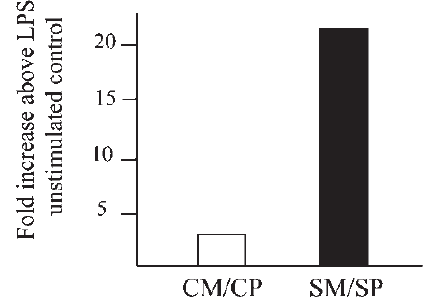
Figure 3. LPS-induced TNF a release is higher in ex vivo hepatocytes generated from the adult IUGR offspring of prenatal calorie restricted rats. We generated primary hepatocyte cell lines as described under “Methods” and assessed the LPS-induced TNF- a release by stimulating them for 5h with purified LPS (100ng/ml), and observed that the TNF- a release was significantly higher in the SM/SP ð n ¼ 2 Þ as compared to CM/CP ð n ¼ 2 Þ : The data shown is the representative of at least three similar